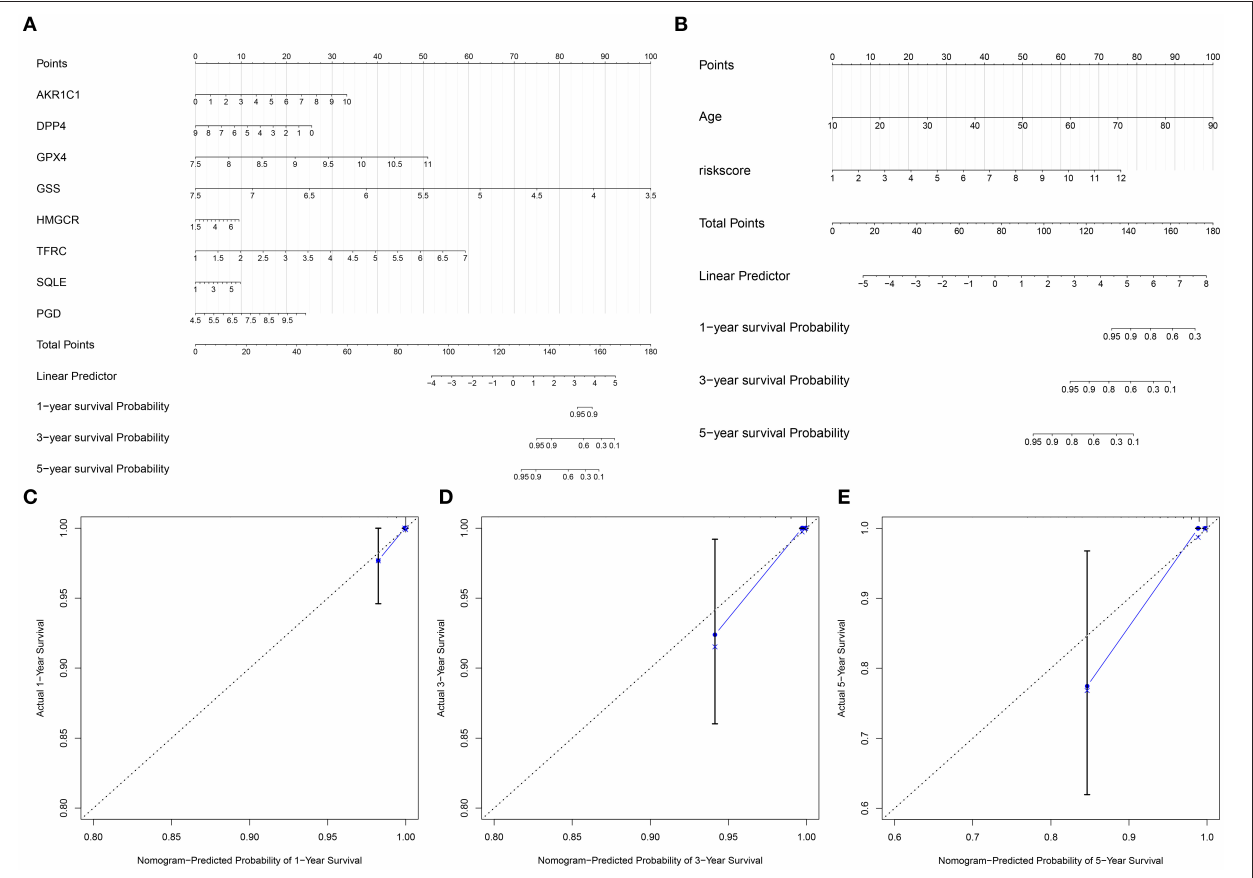
FIGURE 3 | Construction of nomogram models for thyroid cancer. (A) A nomogram combining the eight ferroptosis-related genes. (B) A nomogram combining the risk score and age. (C–E) Calibration curves comparing the nomogram-predicted (C) 1-, (D) 3-, and (E) 5-year survival and actual